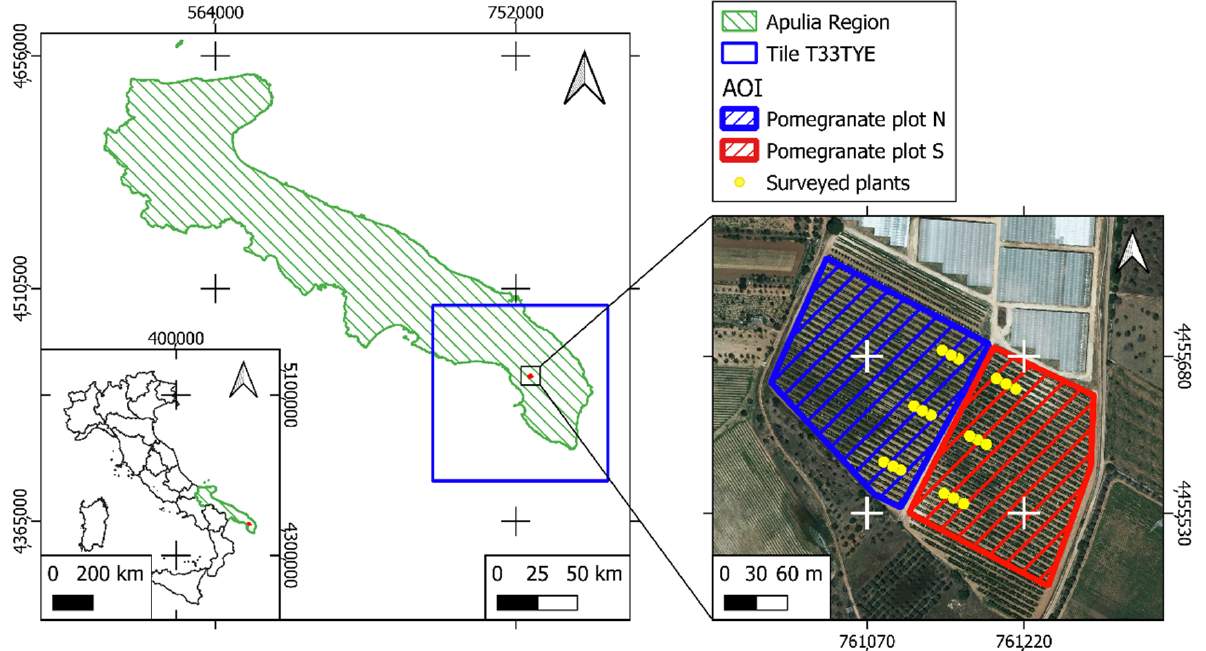
Figure 1. Apulia region (green lined), located in Southern Italy. Pomegranate plots N and S are represented with blue and red lined polygons, respectively. Yellow dots represent the spatial distribution of surveyed pomegranate plants. The S2 T33TYE tile is represented as a blue square in the left frame (the reference system is WGS 84/UTM 33N, EPSG: 32,633).